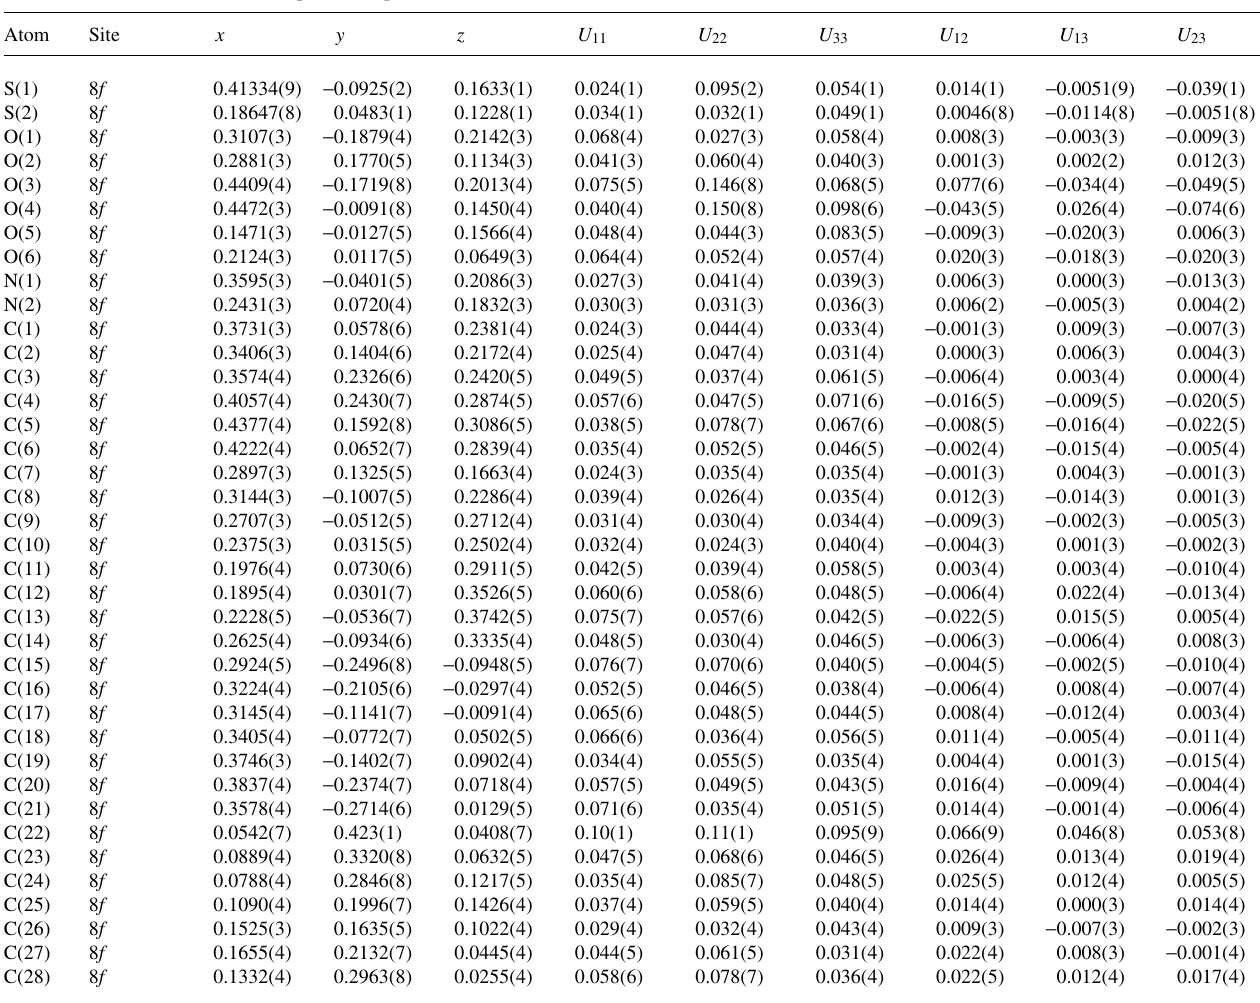
Table 3. Atomic coordinates and displacement parameters (in Å 2 ) .